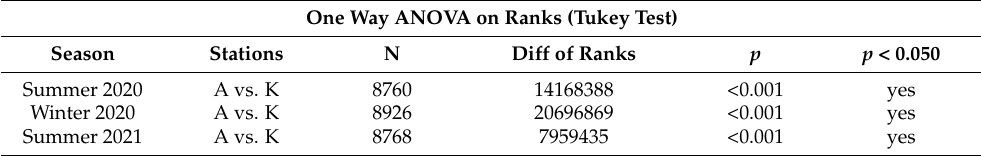
Table 2. One-way ANOVA tests on ranks between the upstream station A and downstream station K for summer 2020 and 2021 and winter 2020. Including number of data points (N), diff of ranks, p -value, and result of test p < 0.050